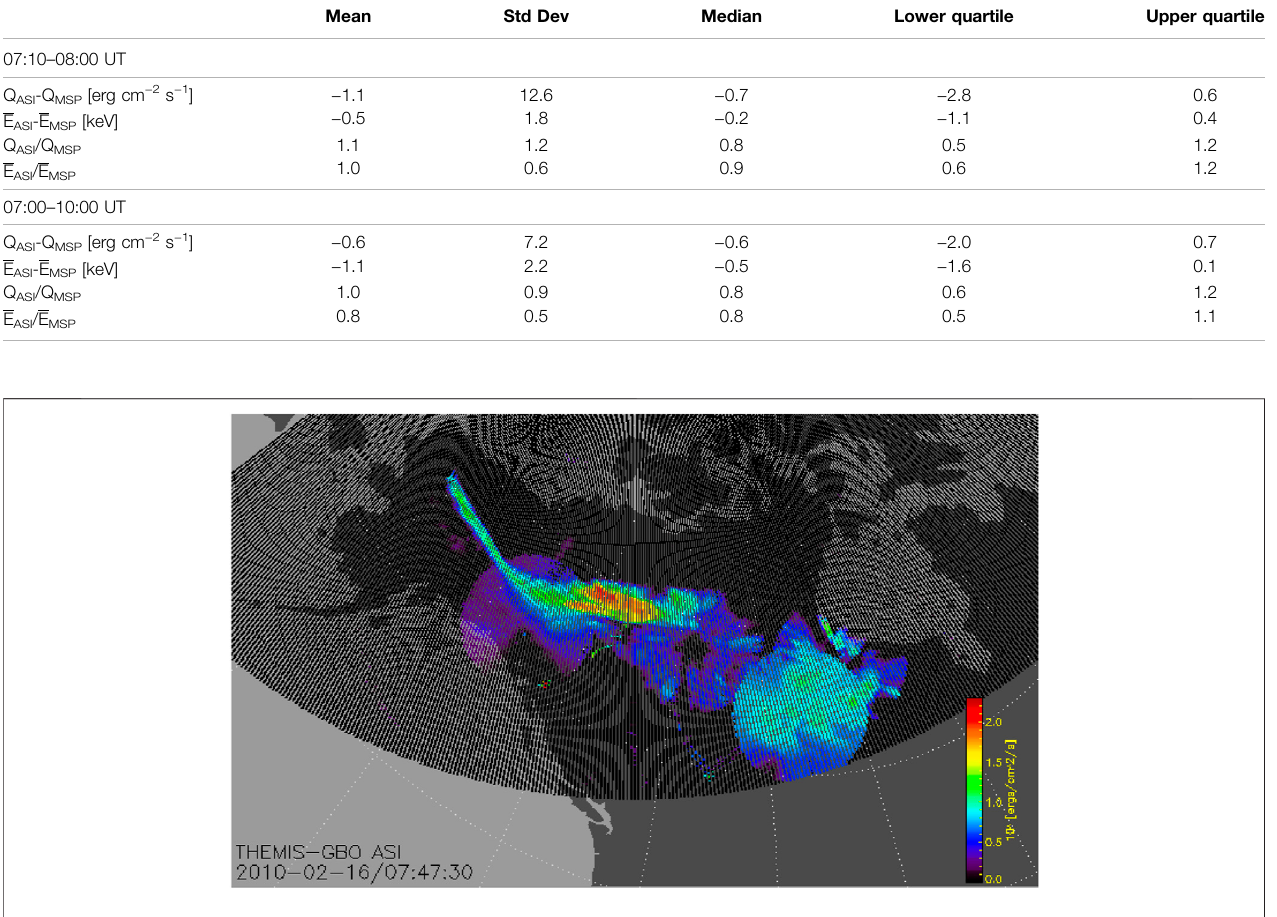
Frontiers in Physics |